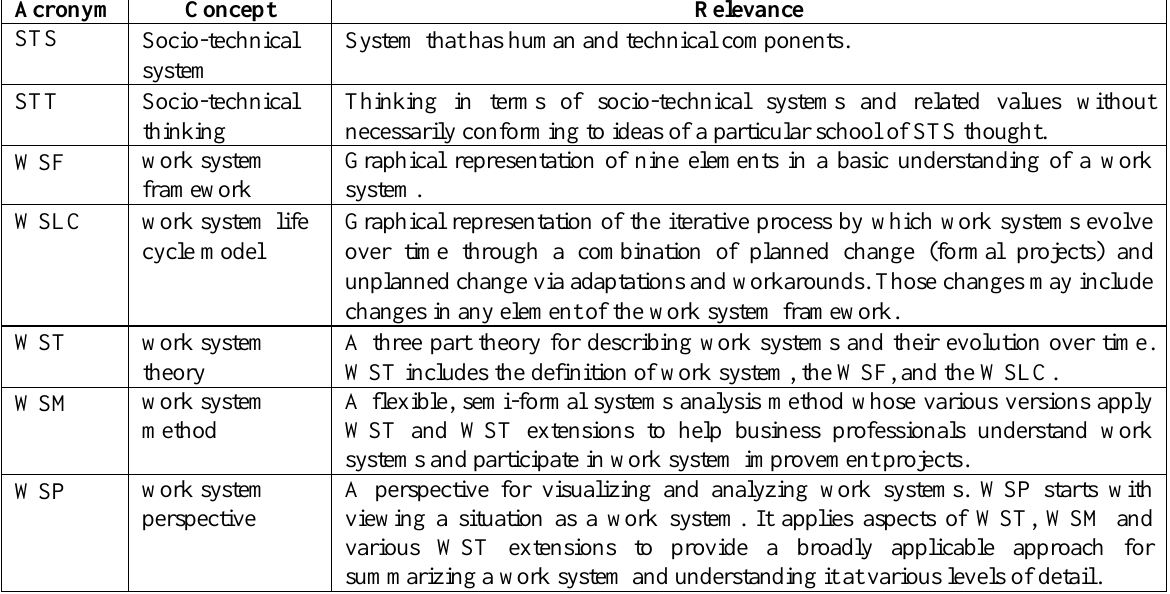
Table 1. Acronyms used in this